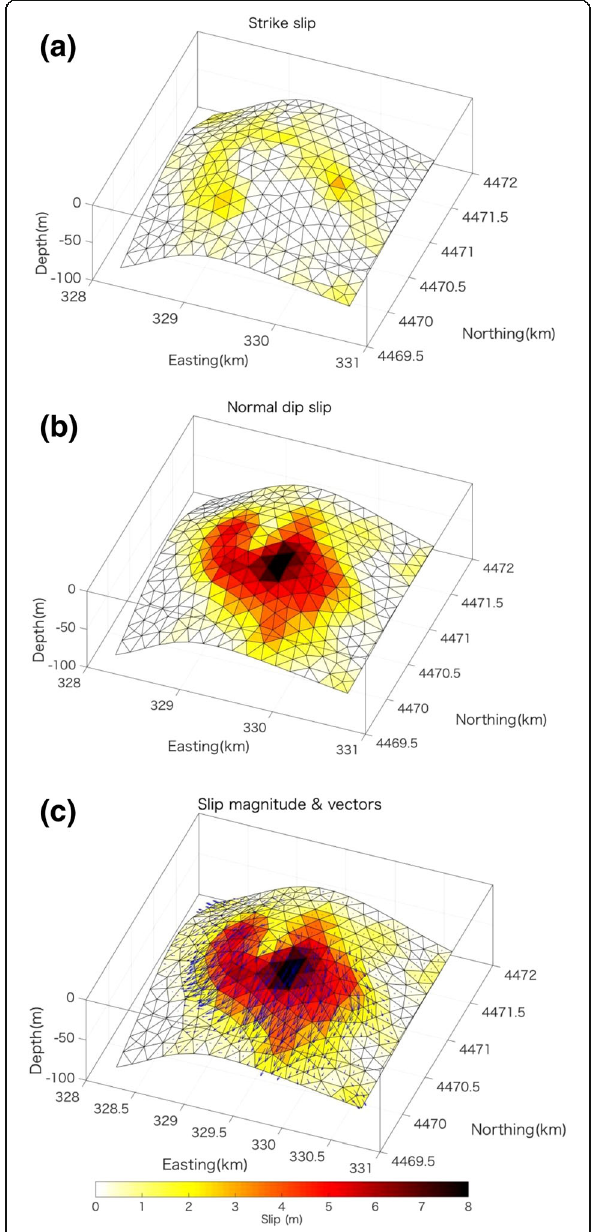
Fig. 12 Slip distributions of a source model inferred from both InSAR and MAI data derived by ALOS/PALSAR. a Strike-slip component. b Normal slip component. c Slip amplitude and vectors. Note that the scales for the vertical axes and horizontal axes are different